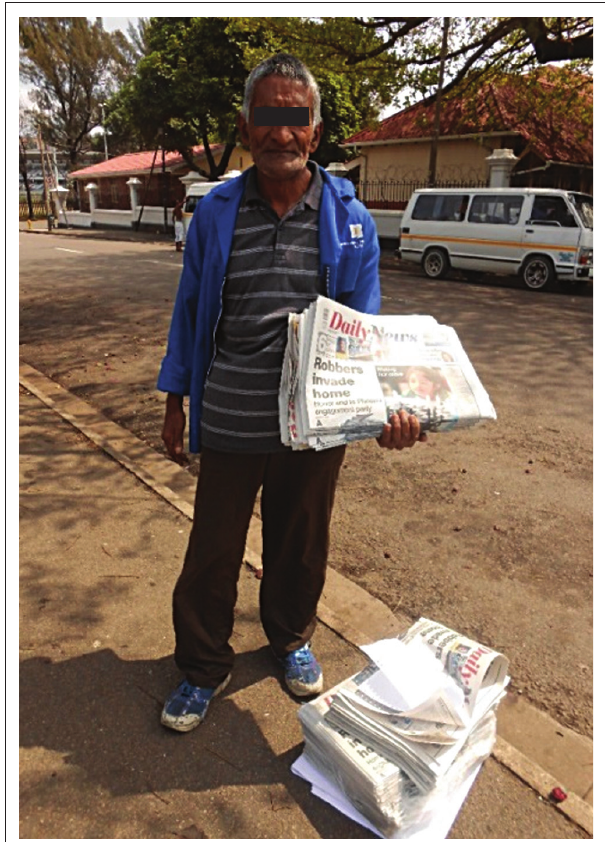
Source : Photo by C. Nnaeme FIGURE 1: Working